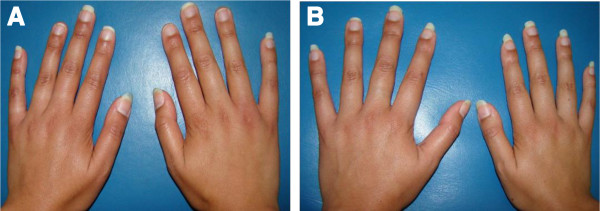
Hands of the twin girls at the age of 19 years. Hand anomalies are not evident in any of the two patients. A) First twin’s hands. B) Picture of the second twin’s hands showing slight hypoplasia of the right one.